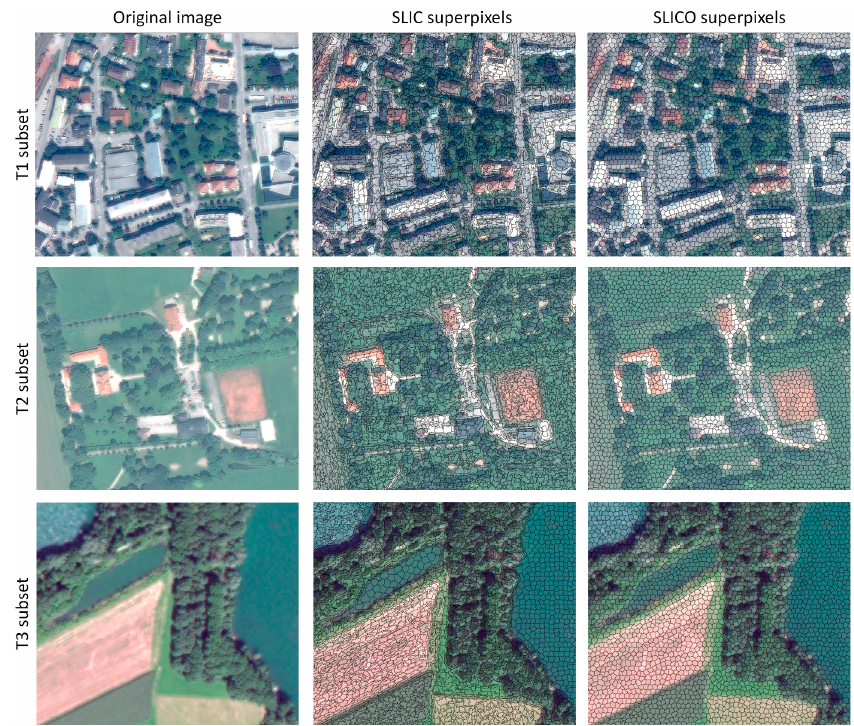
Figure 4. Comparison of Simple Linear Iterative Clustering (SLIC) and SLICO superpixel adherence to natural image boundaries derived using initial clustering of 10 × 10 pixels.